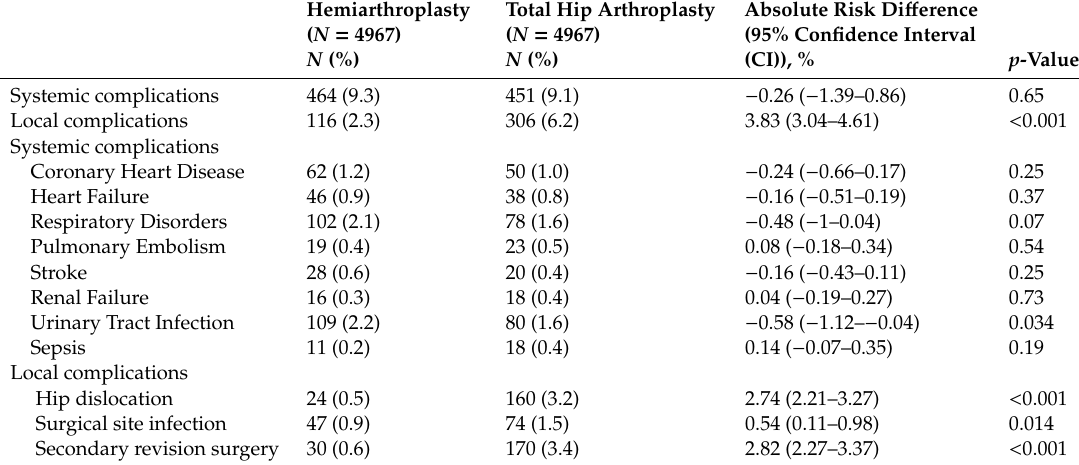
Table 2. Postoperative complications between the propensity score matched groups.